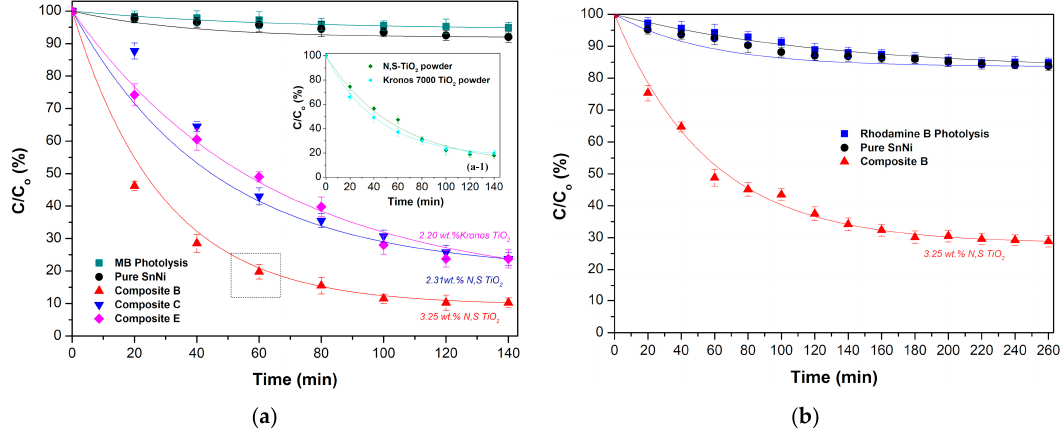
Figure 11. Degradation curves of ( a ) MB and ( b ) RhB as a function of time under visible light irradiation for pure and composite coatings Sn–Ni/doped TiO 2 . The inset (a-1) in Figure 11a depicts the degradation of MB for the two types of doped-TiO 2 powders. In both diagrams the photolysis of ( a ) MB and ( b ) RhB is also included. Lines present exponential decay fitting curves.